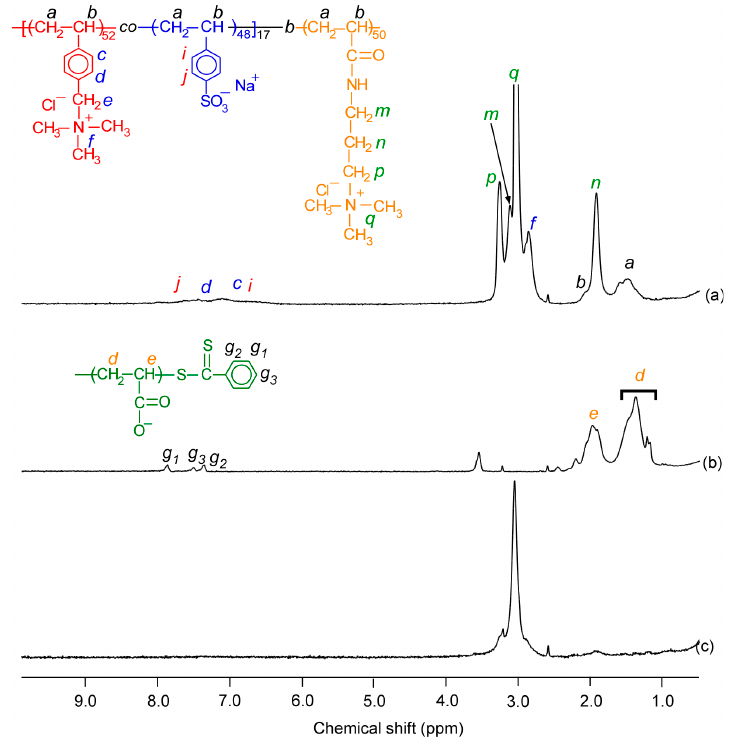
Figure 1. 1 H NMR with water suppression spectra for P(VS) 17 A 50 ( a ), PAAc 49 ( b ), and the P(VS) 17 A 50 /PAAc 49 PIC vesicle with f + = 0.5 ( c ) at C p = 2.0 g/L in D 2 O at pH 10 at 25 °C. Table 1. Degree of polymerization (DP), number-average molecular weight ( M n ), and polydispersity index ( M w / M n ).